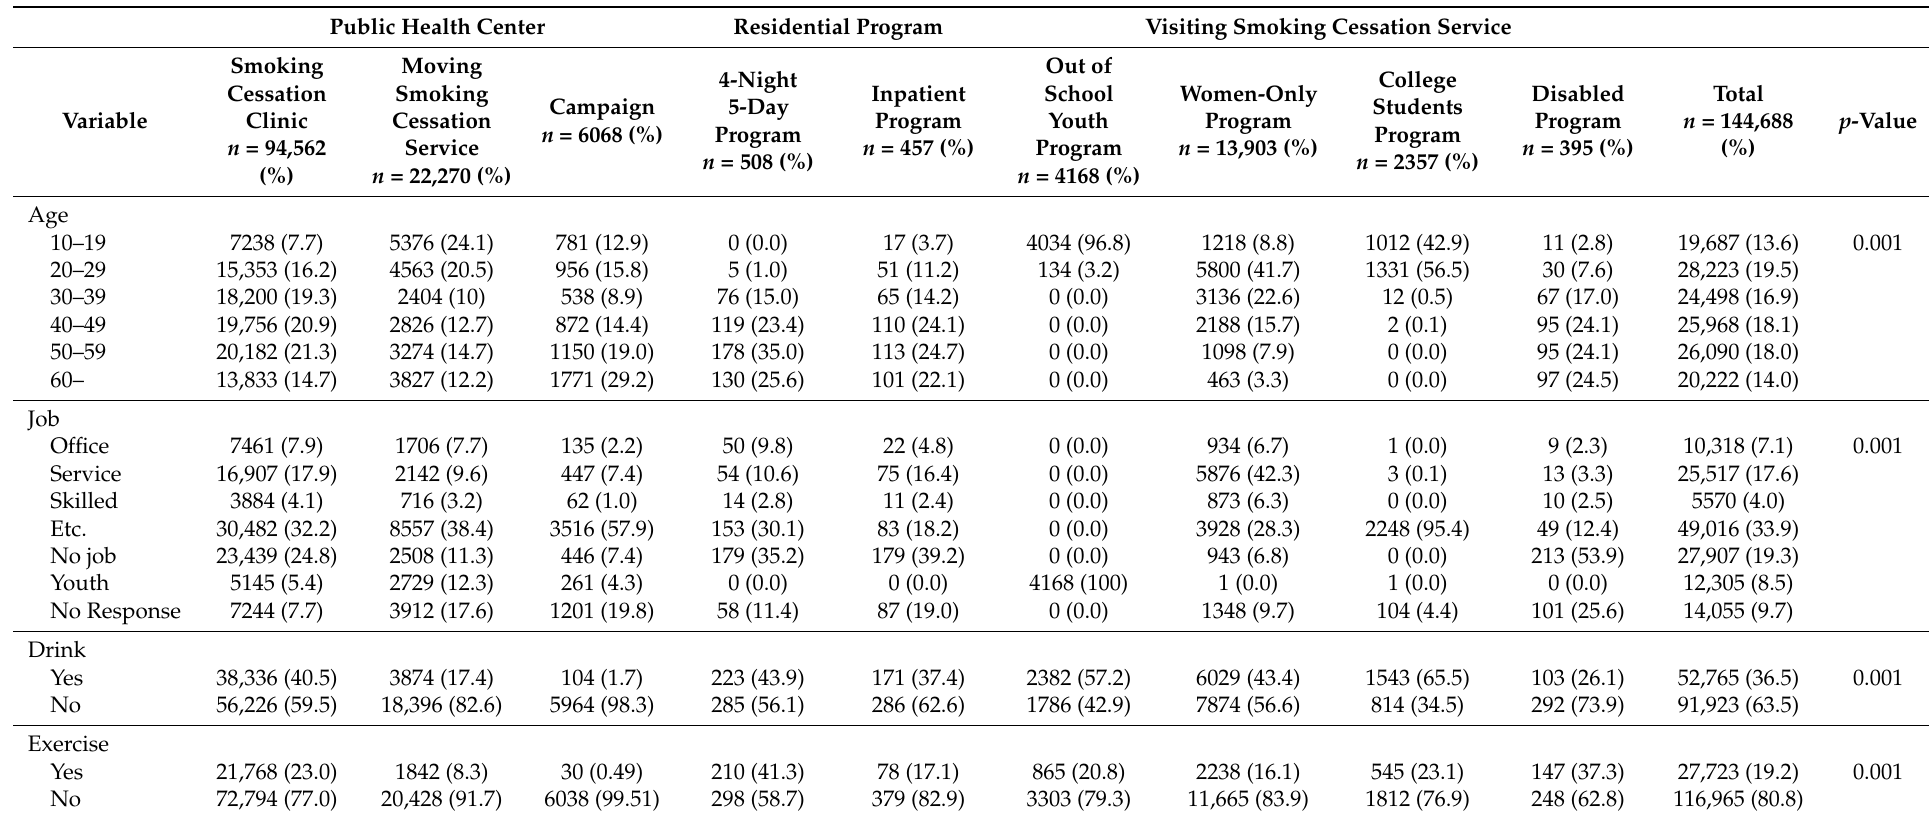
Table 1. General characteristics of study subjects according to various smoking cessation